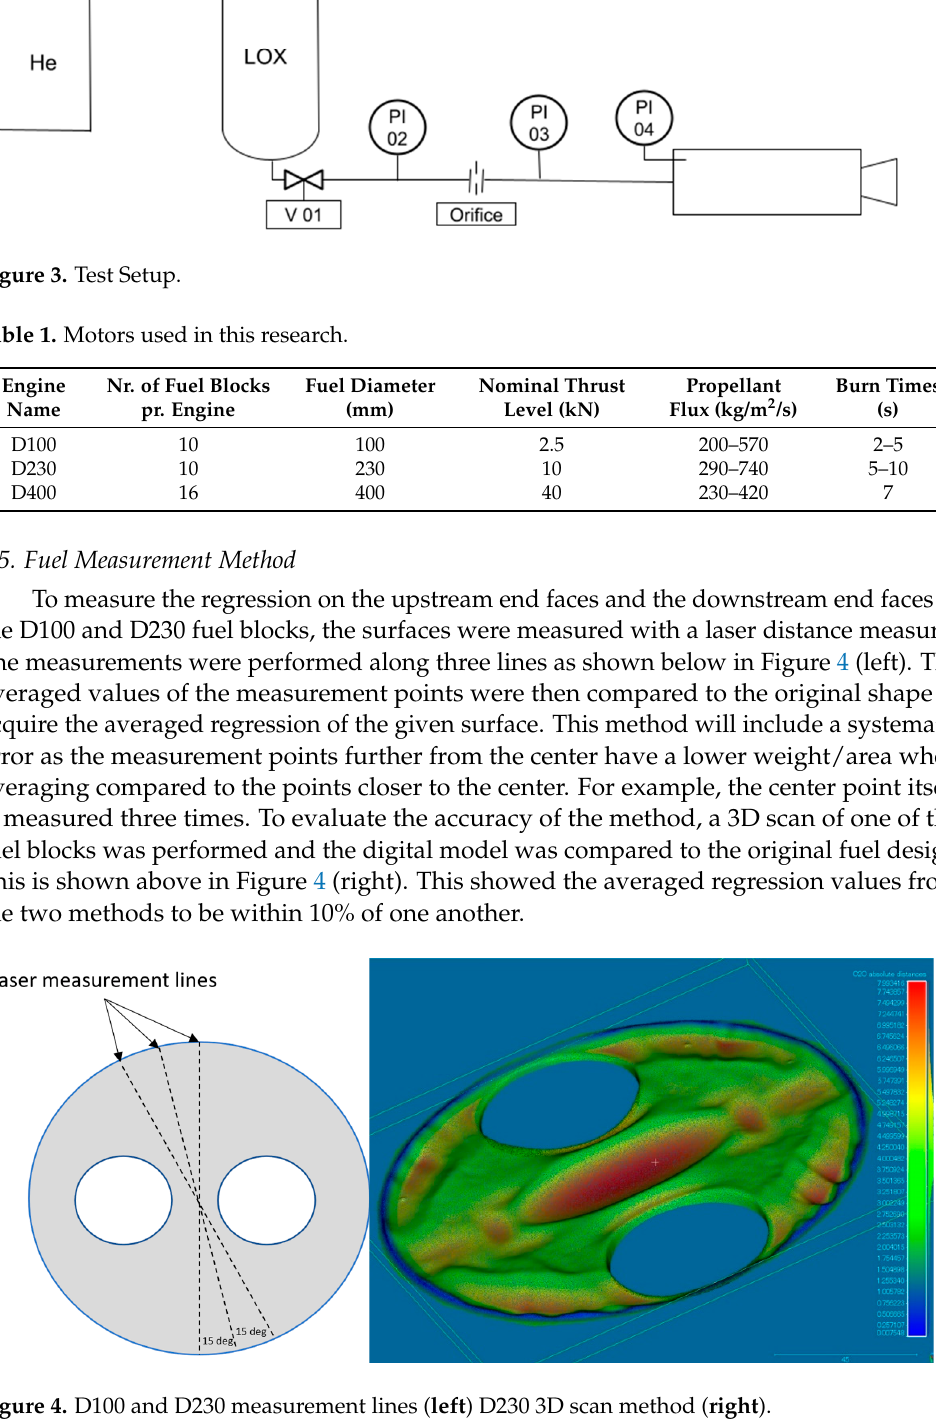
Figure 4. D100 and D230 measurement lines ( left ) D230 3D scan method ( right